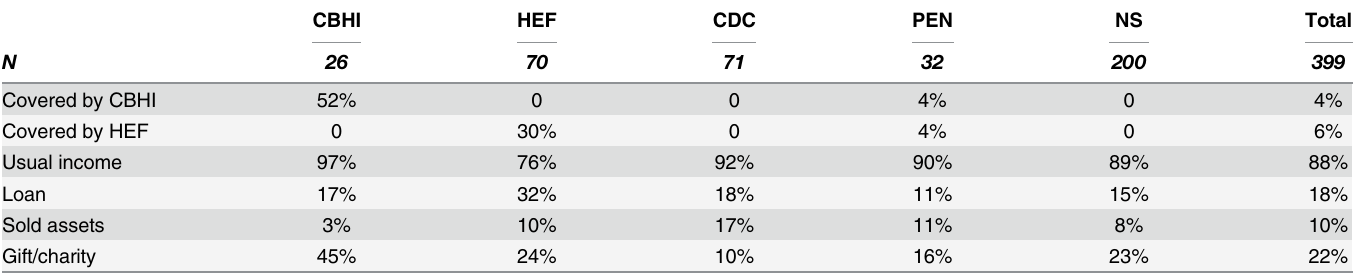
Table 8. Source of money for treatment § 1